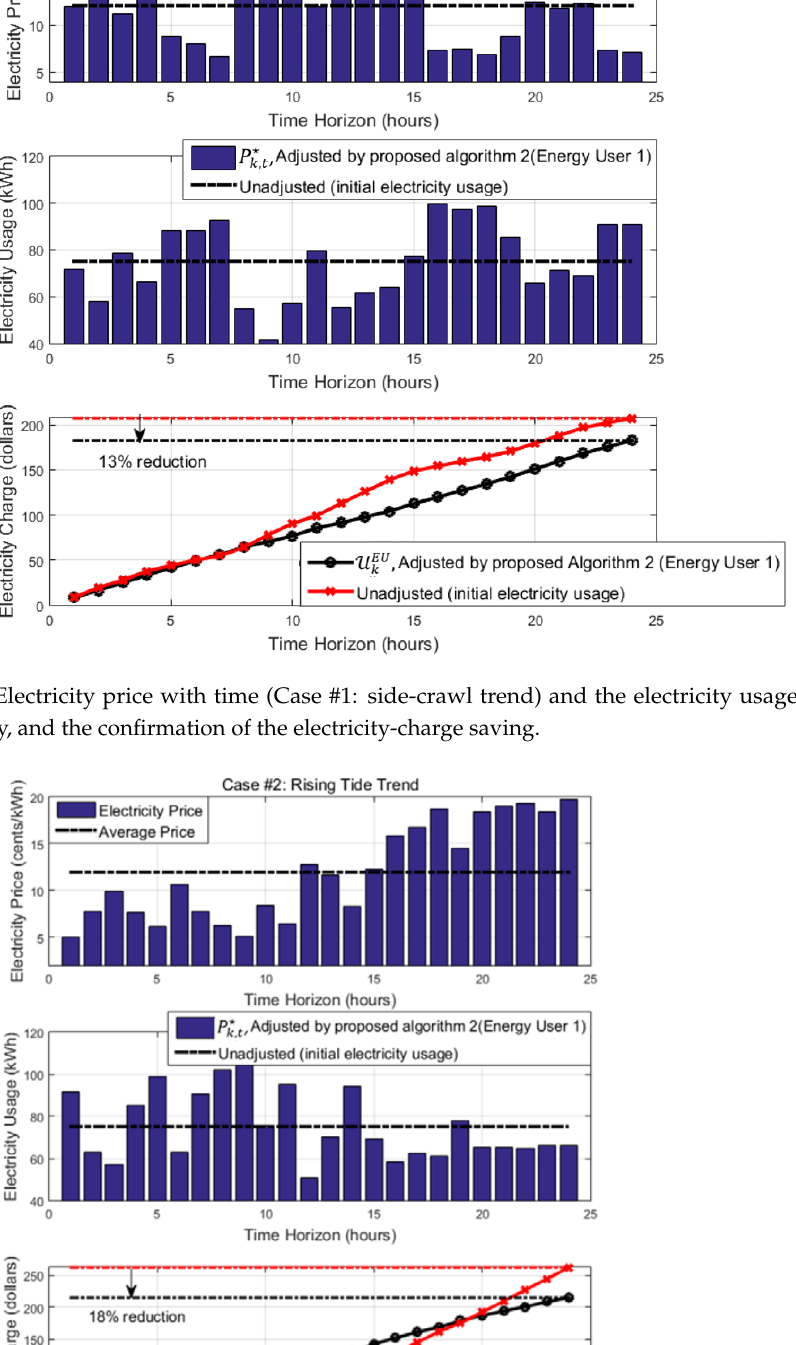
Figure 7. Electricity price with time (case #3: falling tide trend) and the electricity usage adjusted accordingly and confirmation of electricity charge savings.